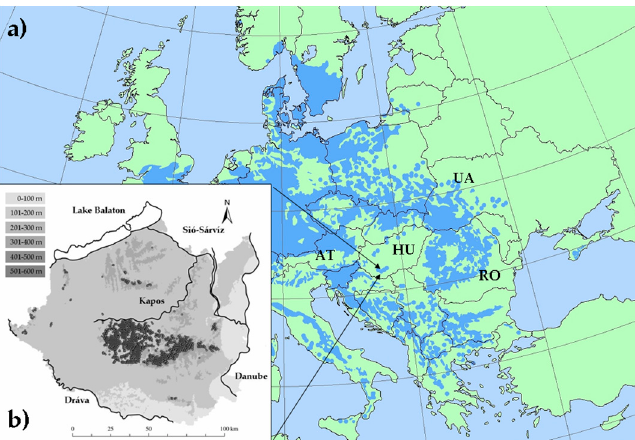
Figure 1. Location and characteristics of the study area. ( a ) Continental-scale distribution of European beech (in blue) [41]; ( b ) Geographic surface of the study area with the main rivers and the Lake Balaton (inland watercourses are not illustrated), and the distribution pattern of beech forests (filled circles); altitudinal zones are indicted by grey shading using the ranges in the upper left corner, southern Transdanubia in Hungary (HU). Some of neighbor countries are also indicated: Ukraine (UA), Romania (RO) and Austria (AT).